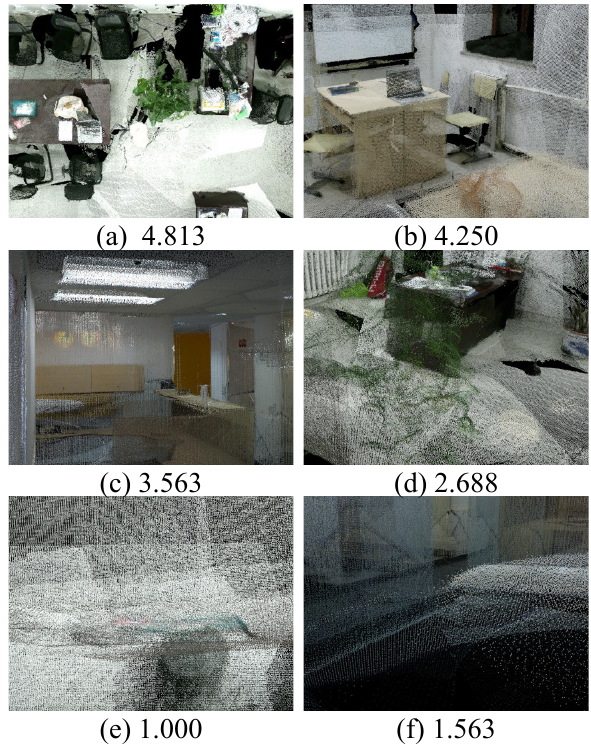
Fig. 5 Representative views from the user study. (a) High-score top view. (b, c) High-score interior views. (d) Low-score interior view (the tree seriously blocks the objects behind). (e, f) Low-score interior